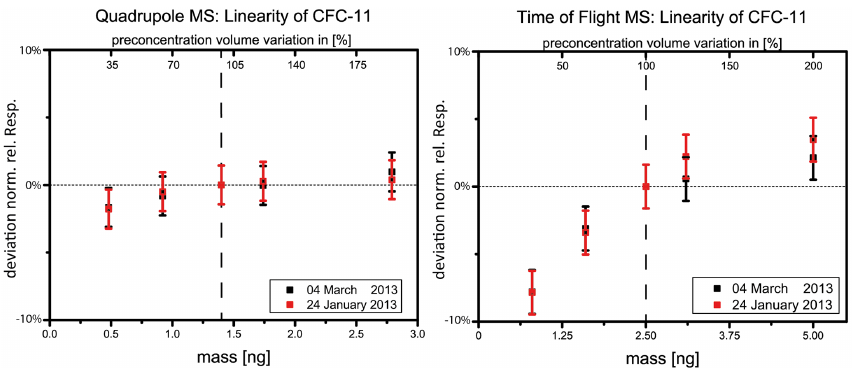
Figure 6. Linearity graphs of CFC-11 (CFCl + fragment) based on two different linearity experiments (red and black plots in each graph). 2 Primary x axis (lower): mass on column in ng. Secondary x axis (upper): preconcentration volume variation in % versus a default precon- centration volume of 0.28L (dashed line). Y axis: deviation from the normalised relative detector response versus the detector response of the default preconcentration volume). For every preconcentration volume, the relative response should be one in case of a linear detector behaviour (dashed line). The error bars show the three-fold measurement precision, on the left-hand side for the QP MS and on the right-hand side for the TOF MS. The second linearity experiment (black) of the TOF MS was conducted with an decreased detector voltage ( − 2274.8V instead of − 2244.8V).